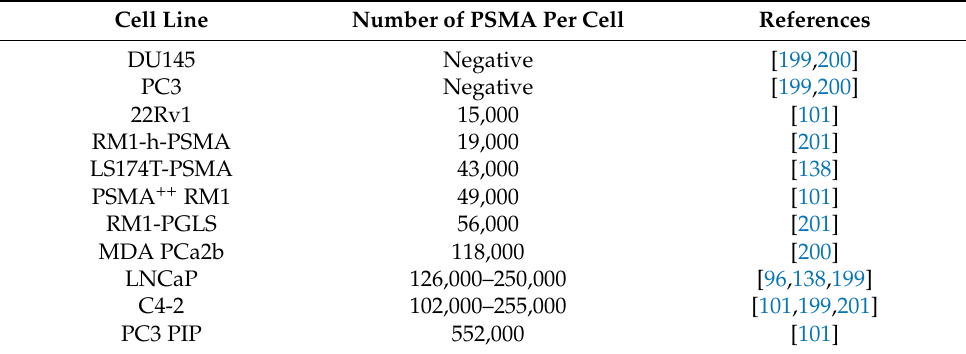
Table 7. PSMA expression in prostate cancer cell lines. N/A, not applicable; negative, below the lower limit of